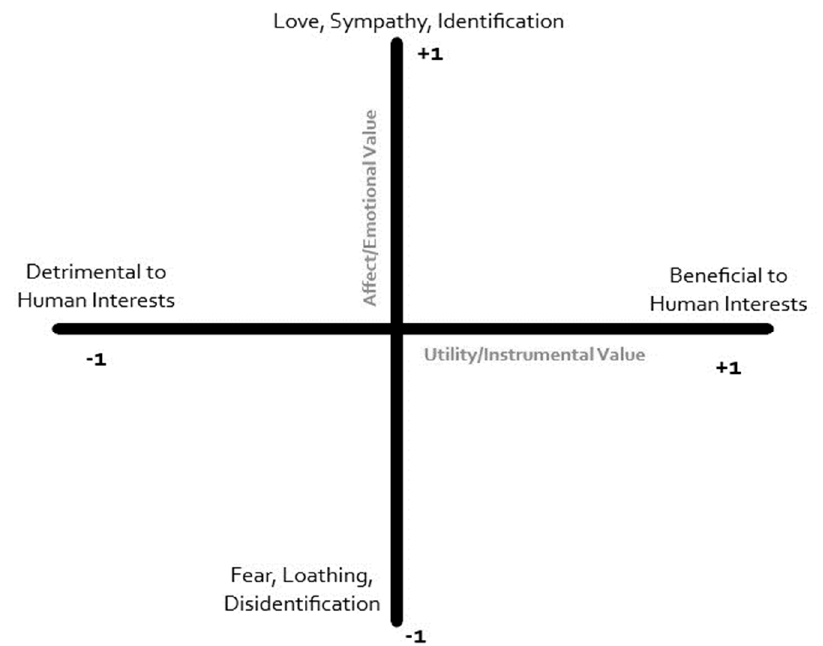
Figure 1. Serpell’s affect and utility biaxial model.